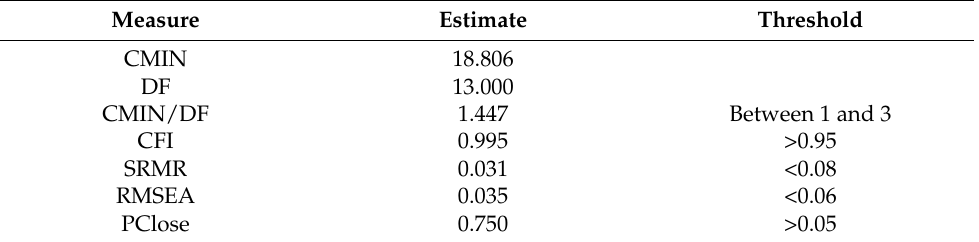
Table 12. Model fit indices.